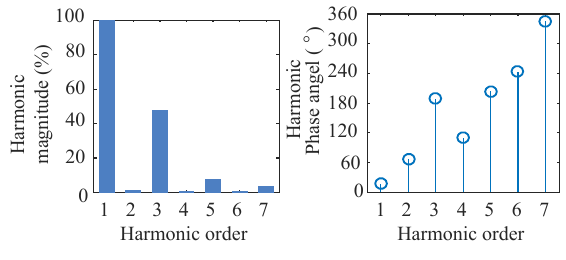
Figure 5. Harmonic spectrum of TV.